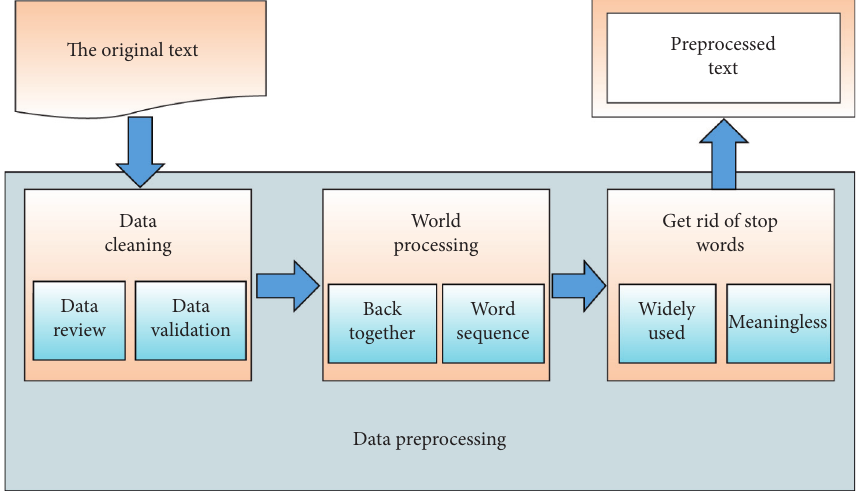
Figure 4: Data preprocessing flow